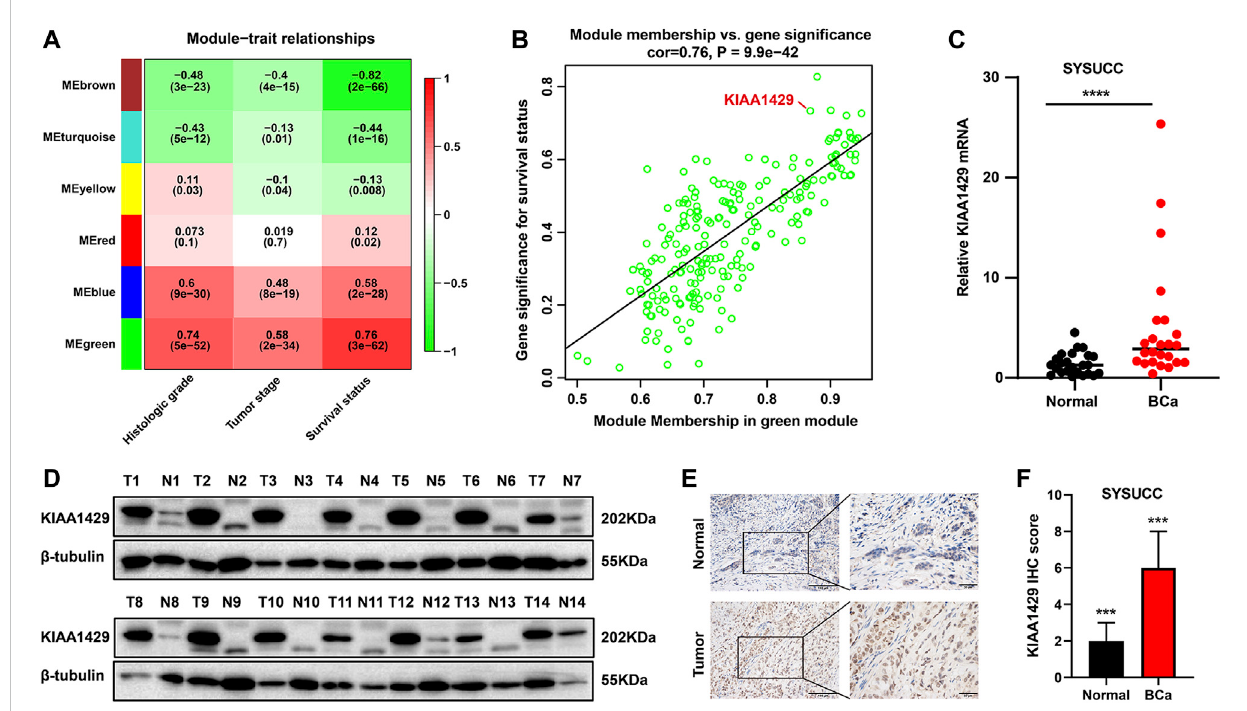
FIGURE 4 Prognosis and expression characteristics of KIAA1429 in BCa samples. (A) Heatmap illustrating the modules-trait correlation between module eigengenes and clinical traits using WGCNA method. (B) Scatter plots showing the correlation between GS and MM of genes in green module using WGCNA method. (C) qRT-PCR analysis revealing mRNA expressionlevelsof KIAA1429 in SYSUCC samples. GAPDH was served as an internal control. (D) WesternblotanalysisshowingincreasedKIAA1429proteinlevelsinBCatissues,comparedtothepairedadjacntnormalbladderurothelialtissues. (E) Representative IHC images exhibiting KIAA1429 expression in BCa samples and adjacent normal bladder urothelial tissues. Original magni fi cation, ×200. (F) IHC score of KIAA1429 staining in BCa tissues and corresponding non-cancerous